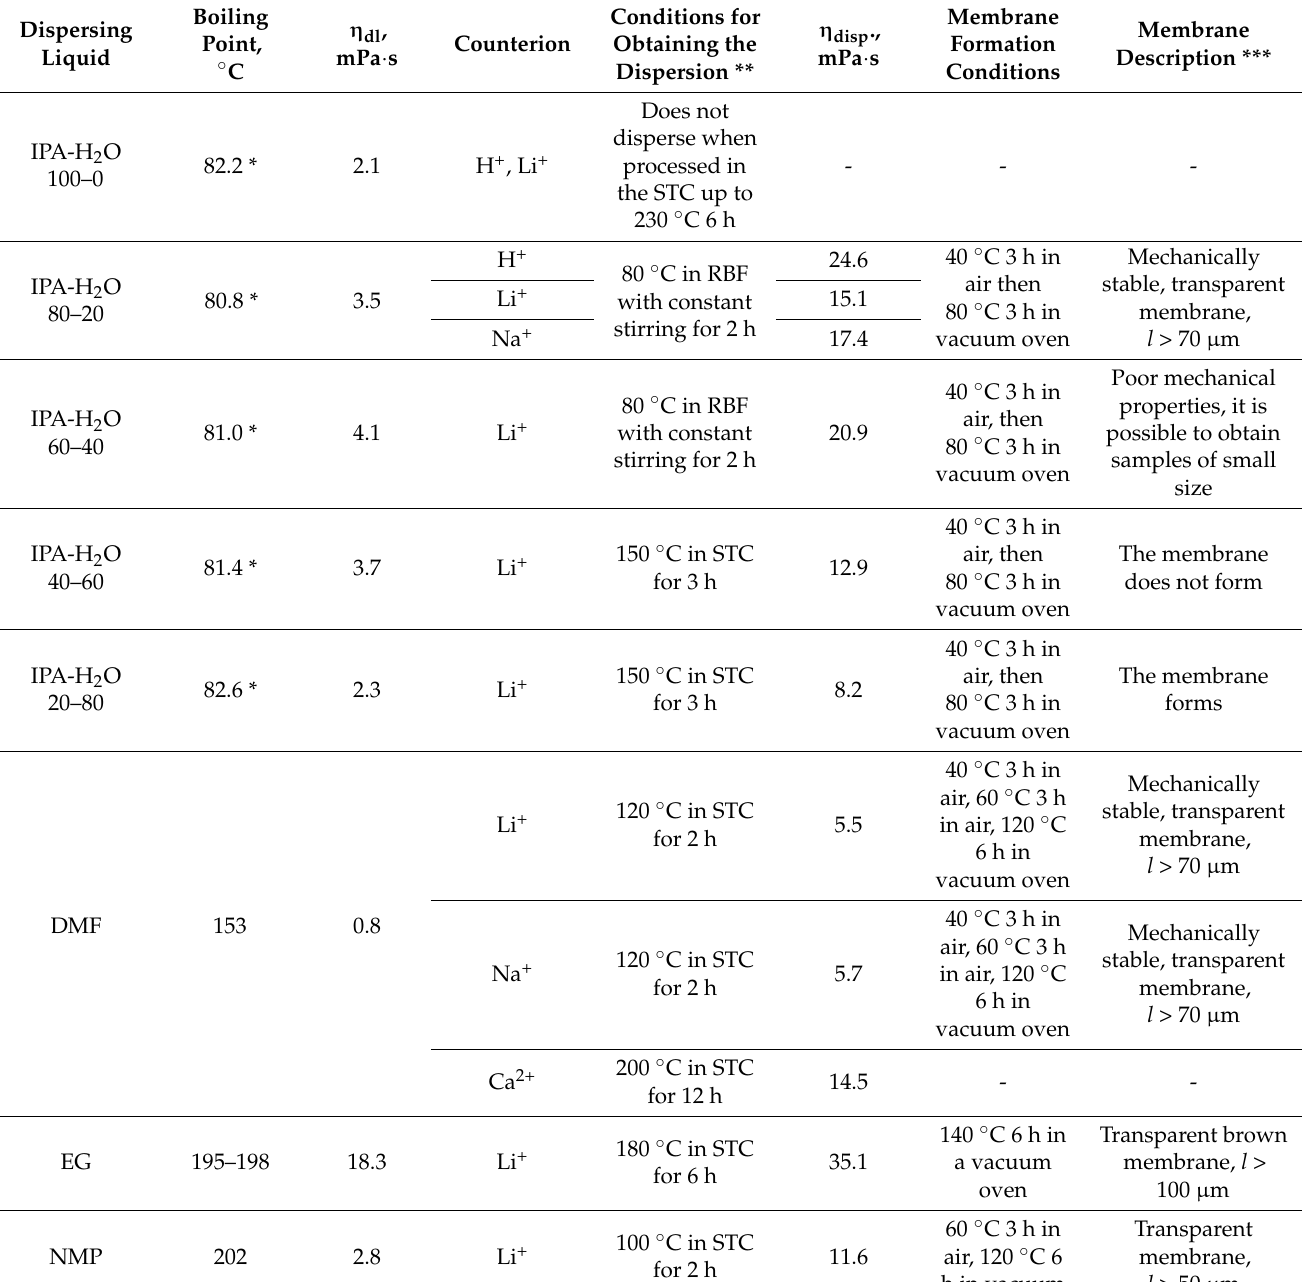
Table 1. Conditions for obtaining dispersions, viscosity ( η , mPa · s at 25 ◦ C) of dispersing liquids ( η dl ) and dispersions ( η disp ) containing 5 wt.%, Nafion